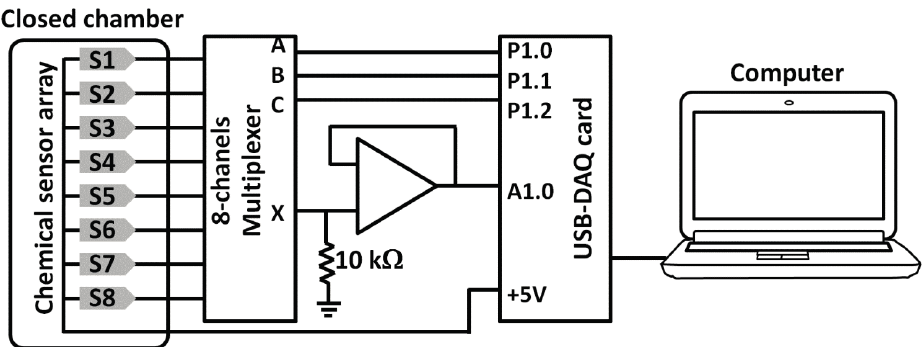
Figure 2. Measurement diagram using a voltage divider method with buffer amplifier for the sensor response under a static